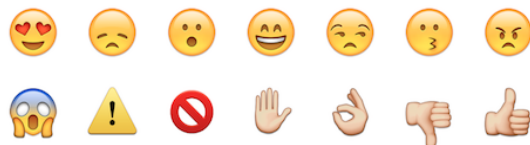
Figure 3. Emoticon stickers used in the Liverpool map-making workshops.